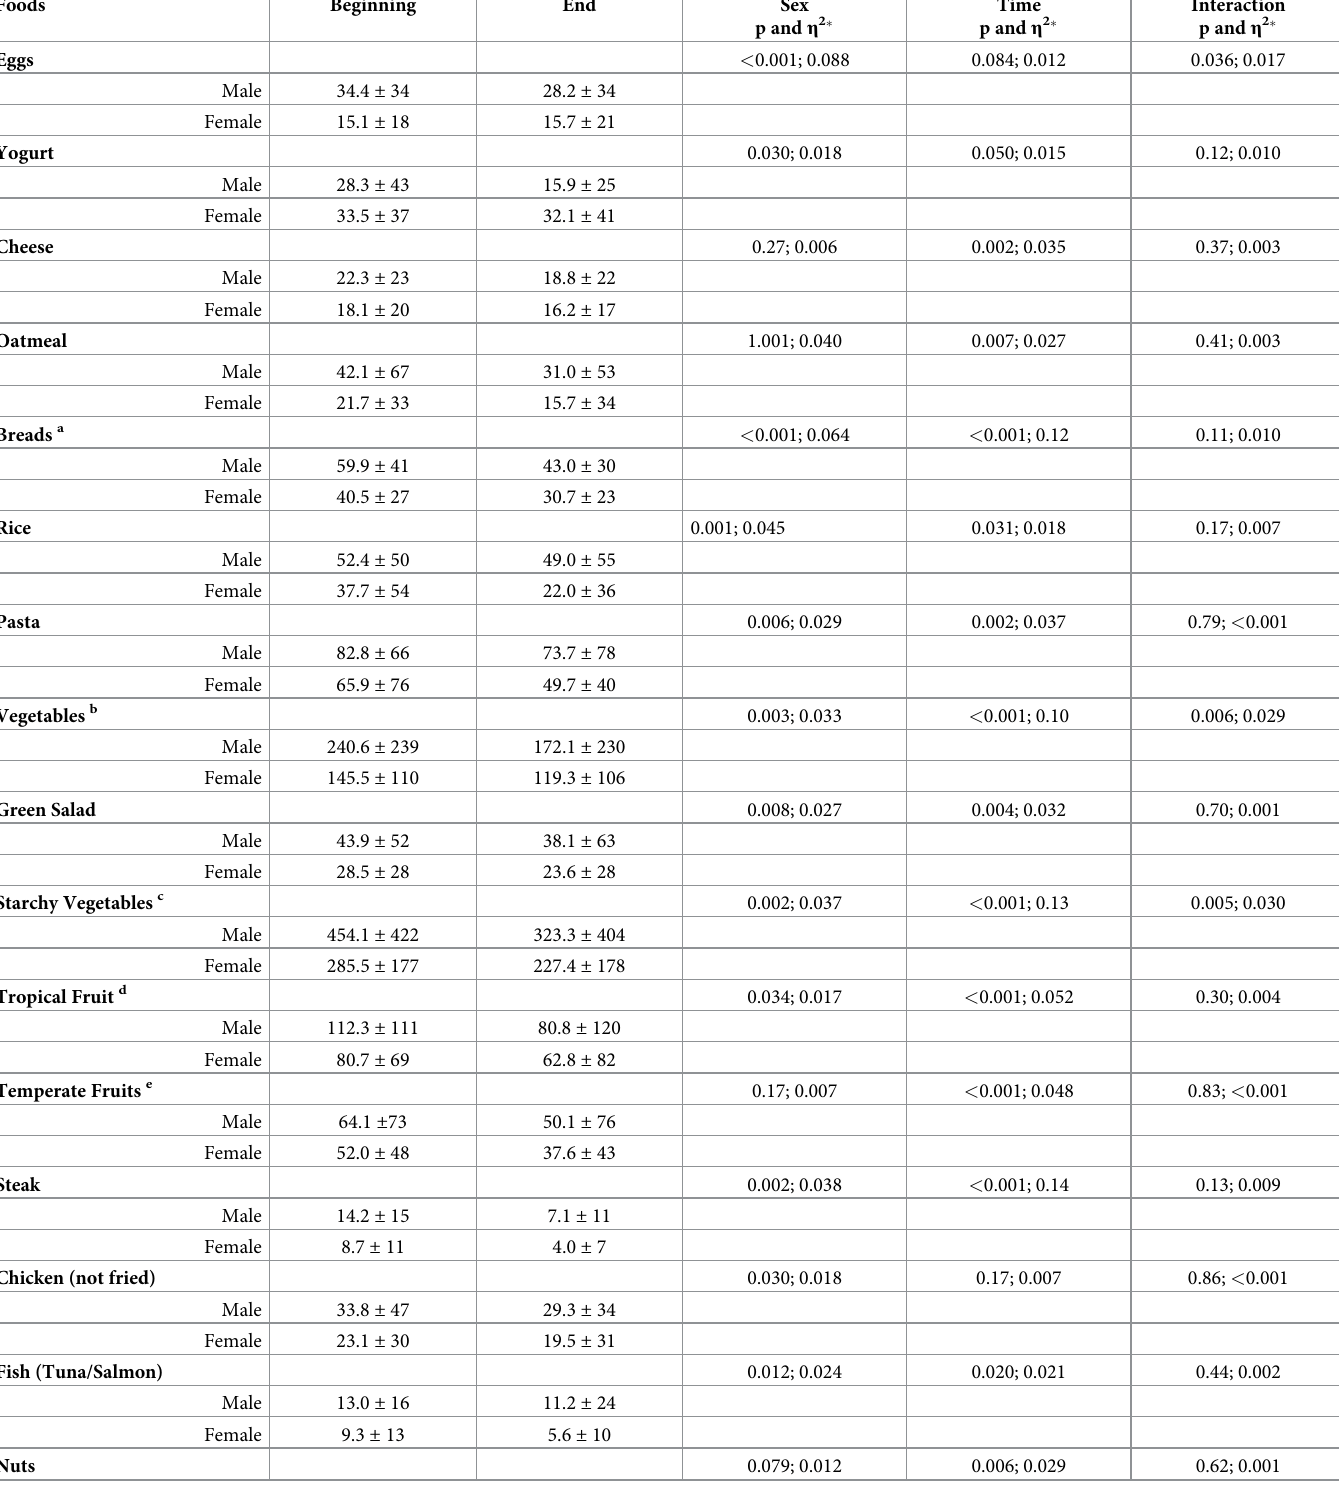
Table 3. Assessing diet quality: Foods that are generally seen as part of a healthy diet. Intakes (g/day) are from beginning to end of first-year university in male (n = 50) and female (n = 210) students.